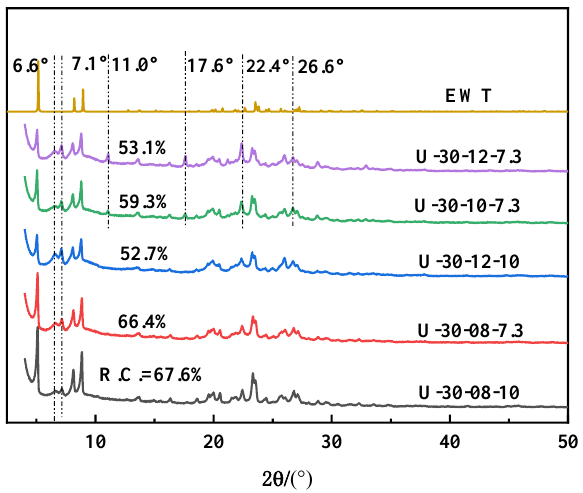
Figure 3. The XRD pattern of samples with n (SiO 2 )/ n (B 2 O 3 ) = 30.